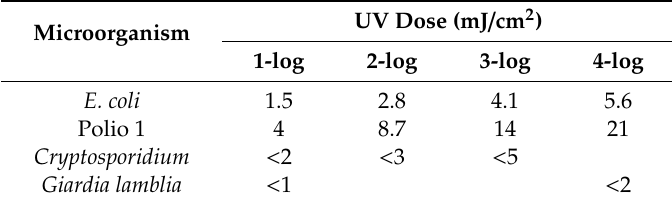
Table 9. UV dosage required to achieve given log inactivation of various microorganisms, as noted by the USEPA, 2003 [223].